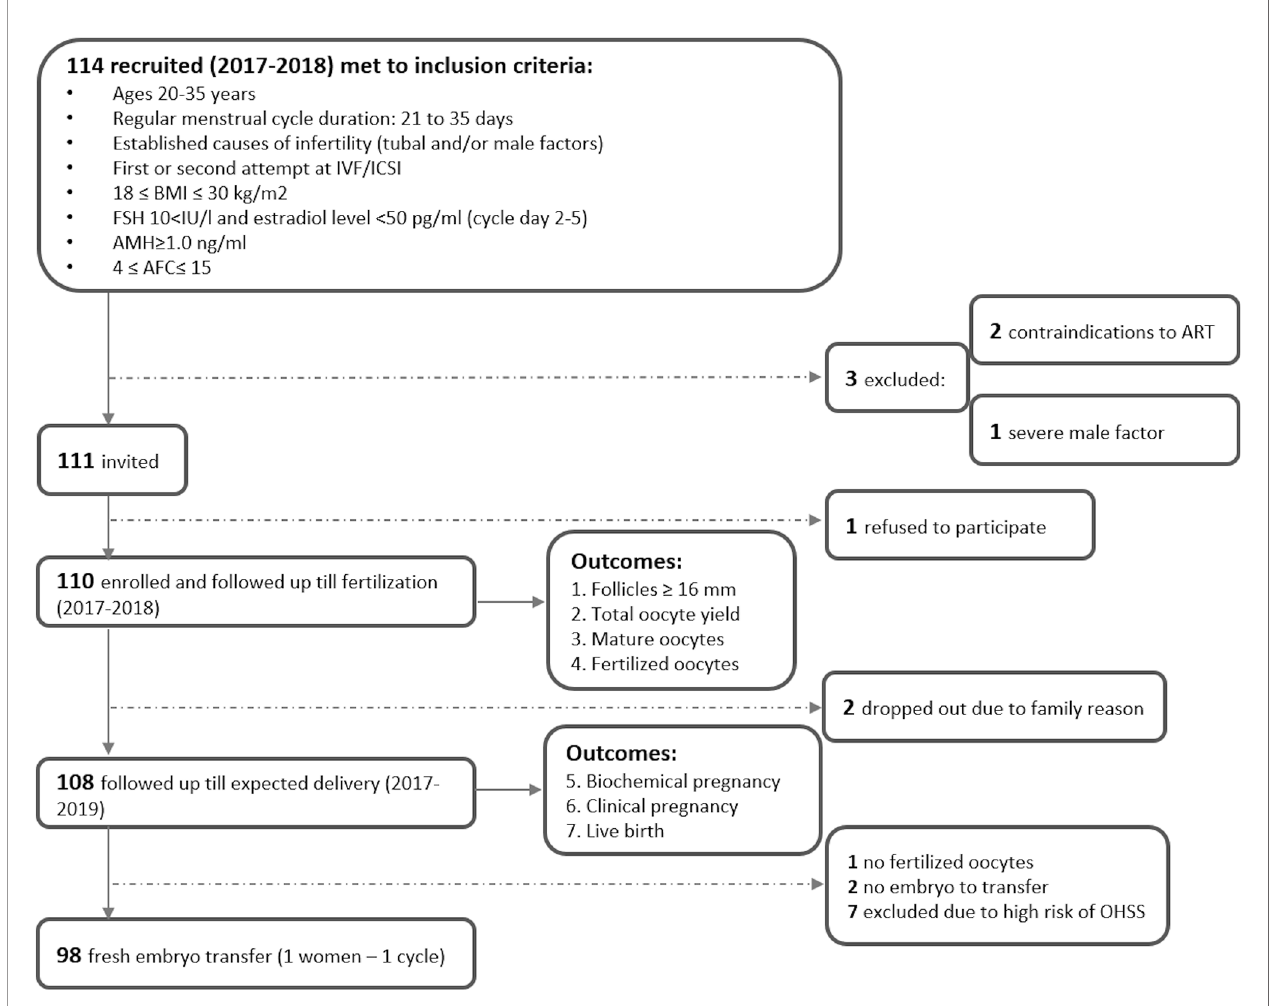
FIGURE 1 | Flowchart of recruitment and follow up study